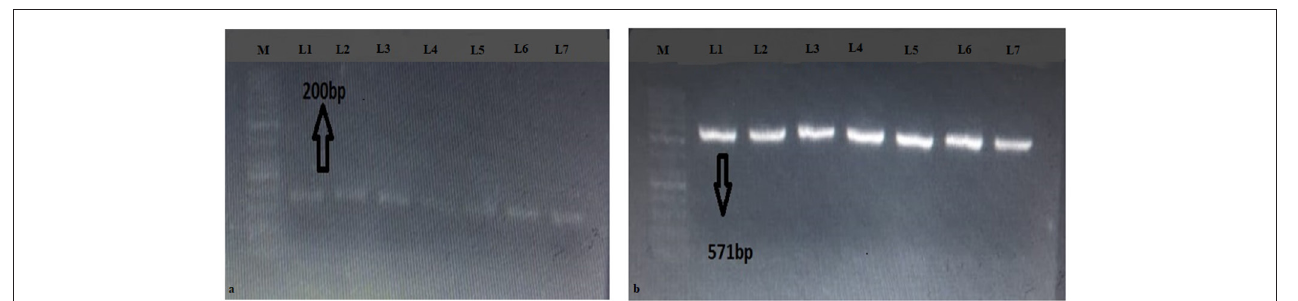
FIGURE 2 | Gels of (a) LSU (rrnl) and (b) NAD1 genes. M represents 50 bp DNA ladder; L1-L7 represent positive